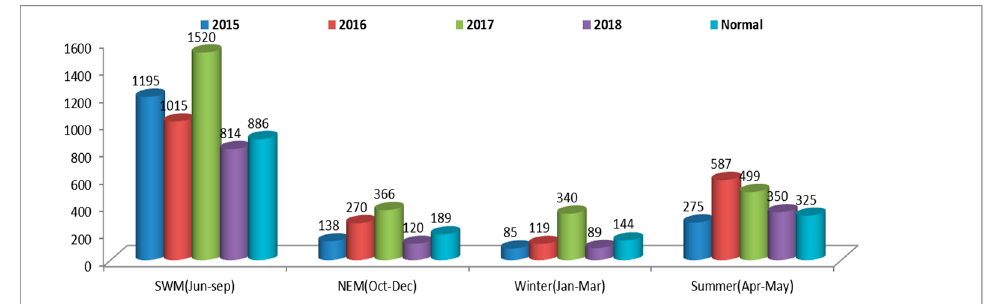
Figure 2. Rainfall during the cropping seasons from 2015–2018 with normal rainfall of Manipur. SWM —South West Monsoon; NEM—North East